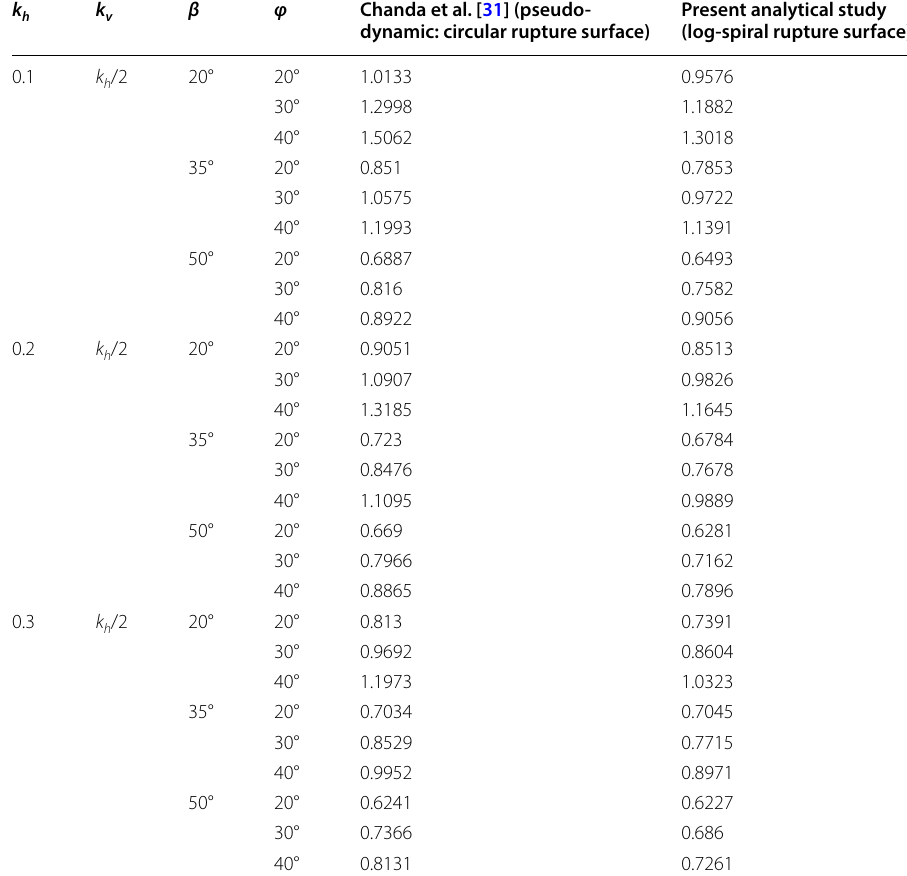
Table 4 Comparison of present results with the results obtained from pseudo-dynamic analyses in the available literature k h k v β φ Chanda et al. [31] (pseudo‑